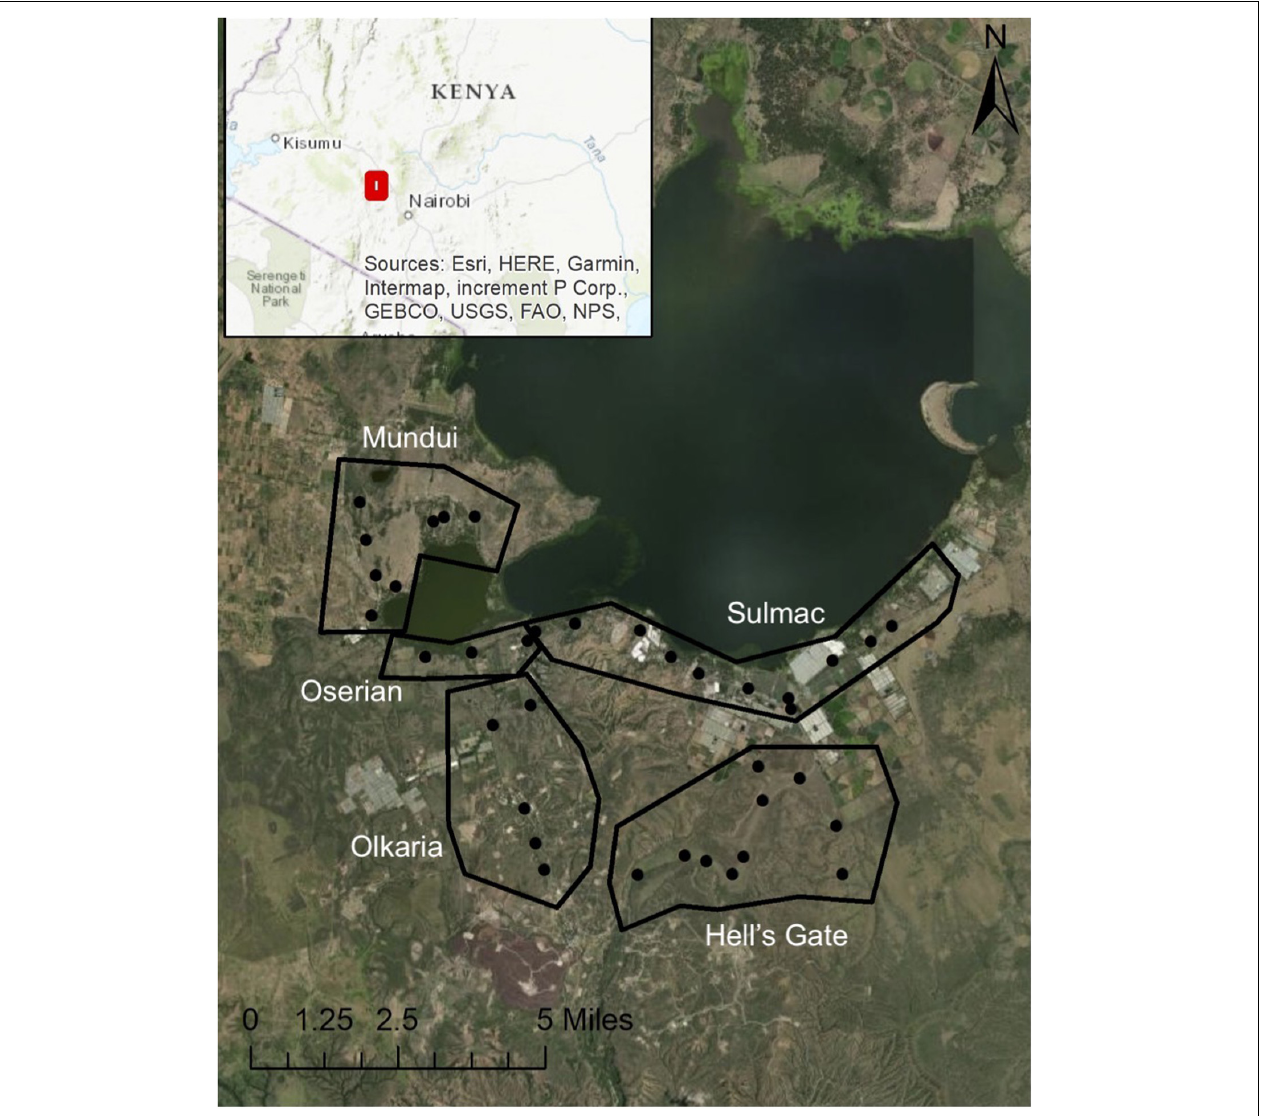
FIGURE 1 | A map of the southern Lake Naivasha region, with polygons showing the general locations of each study area and points showing centers of buzzard territories as found in 1995. Esri, Maxar, Earthstar Geographics, USDA FSA, USGS, Aerogrid, IGN, IGP, and the GIS User Community.